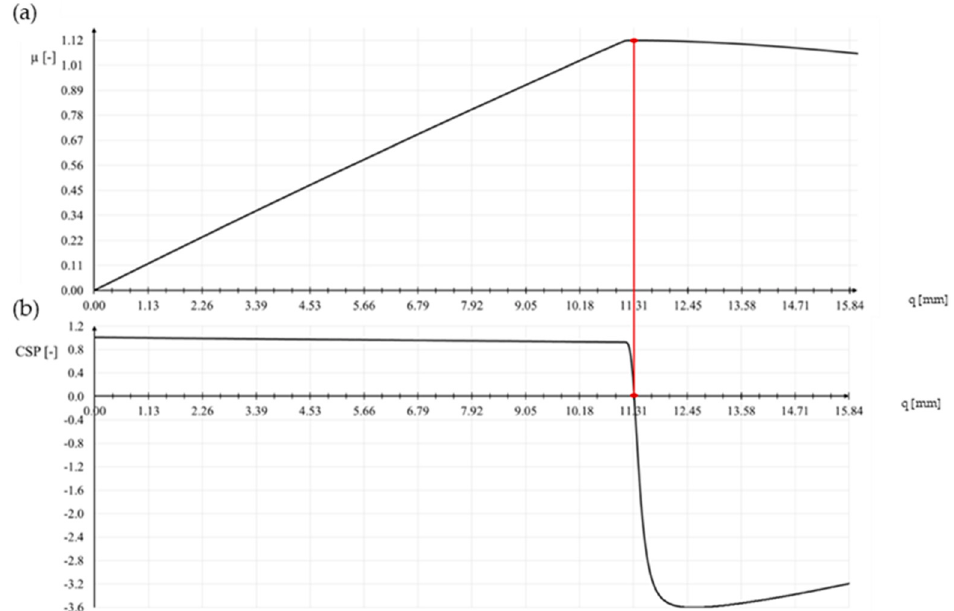
Figure 10. ( a ) Equilibrium path, ( b ) CSP-q relationship.